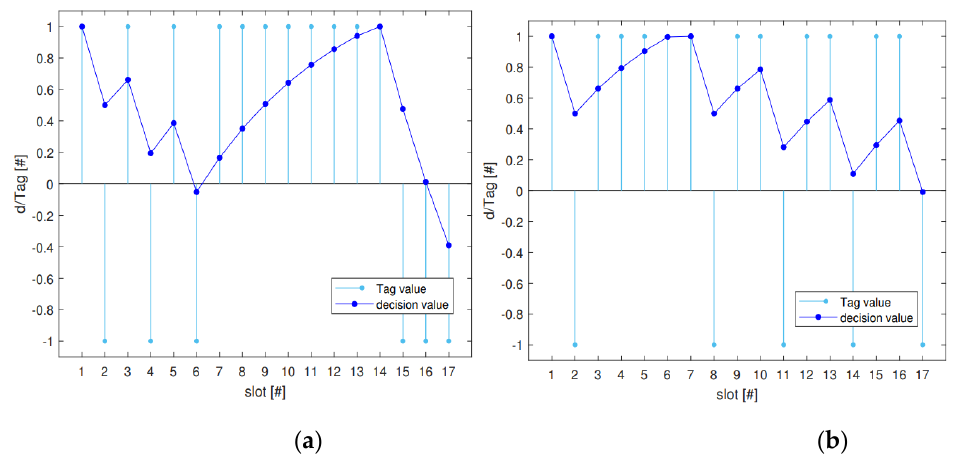
Figure 6. ( a , b ) Change curve of decision value with Tag value.